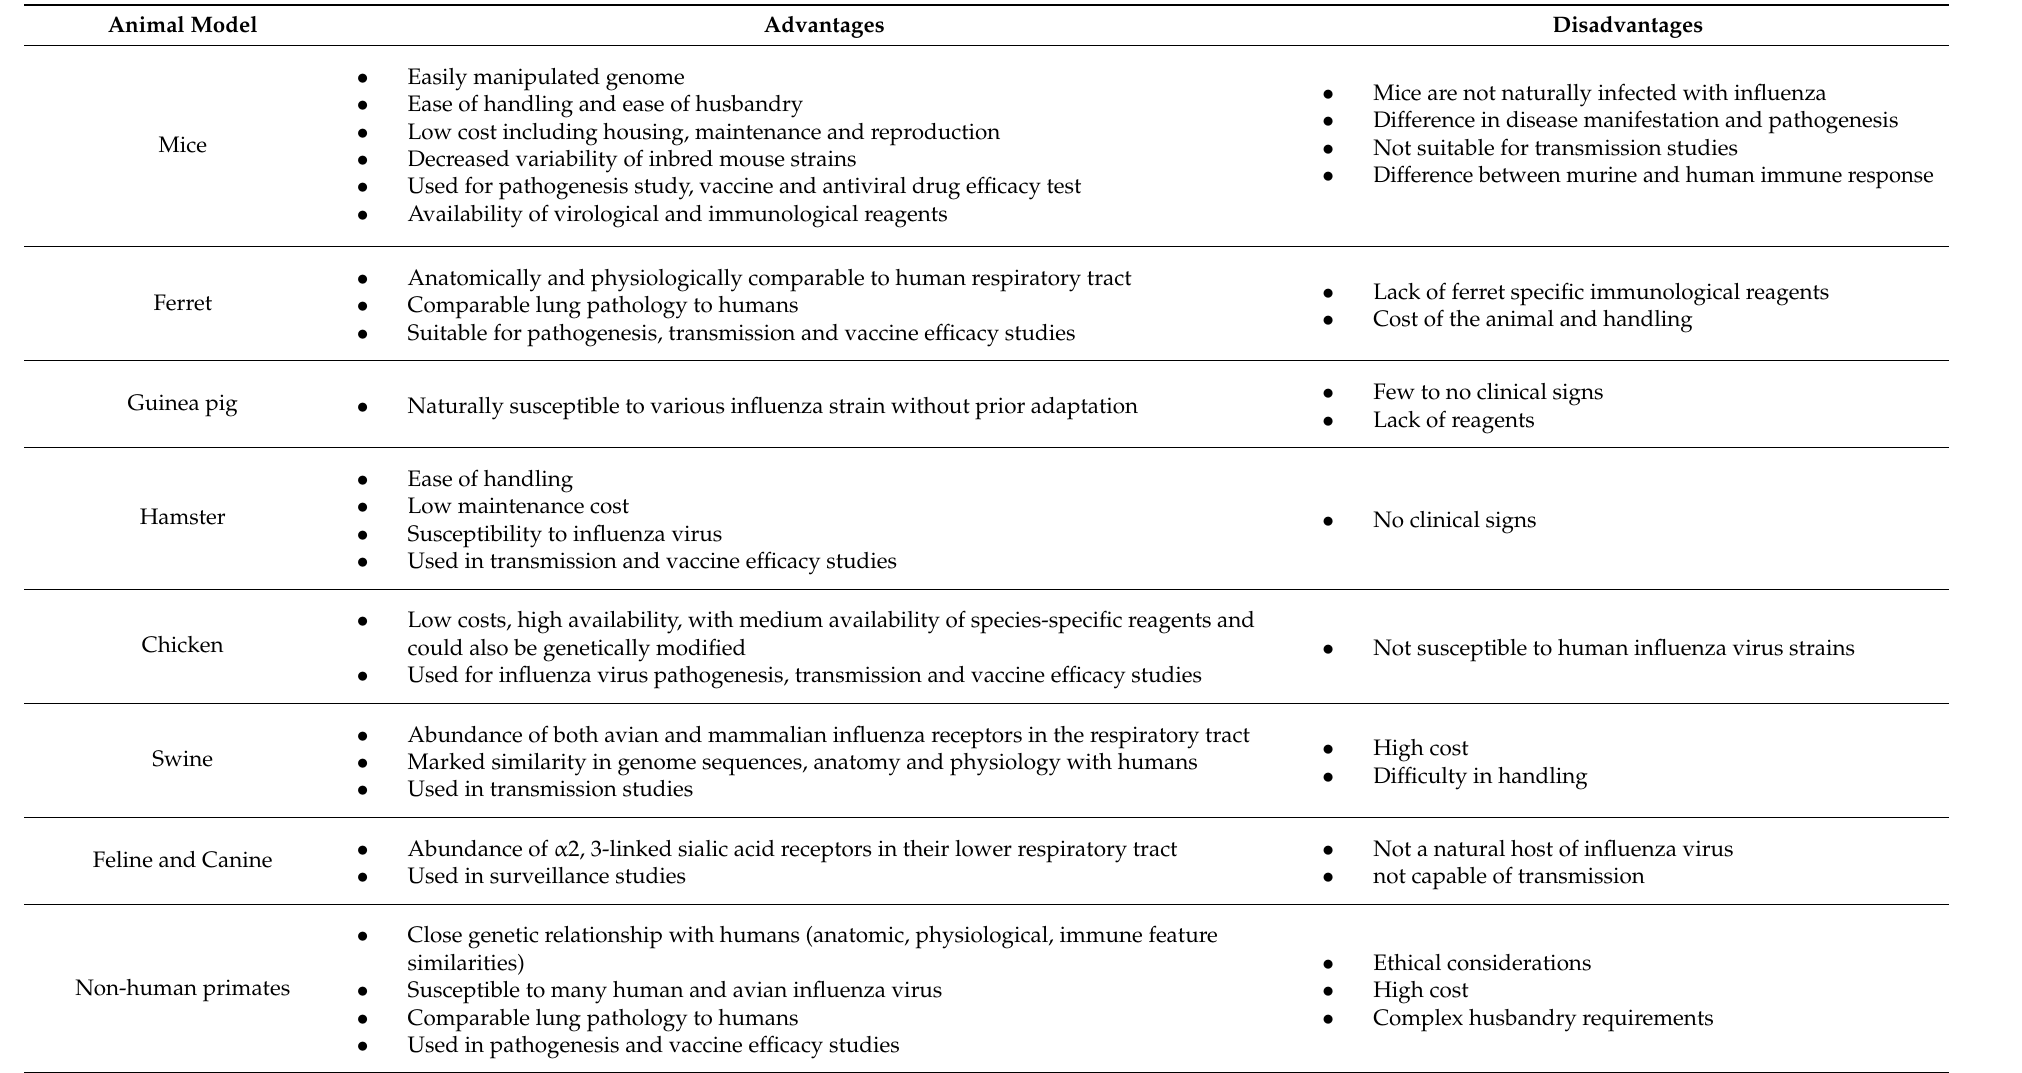
Table 3. The advantages and disadvantages of animal models in influenza